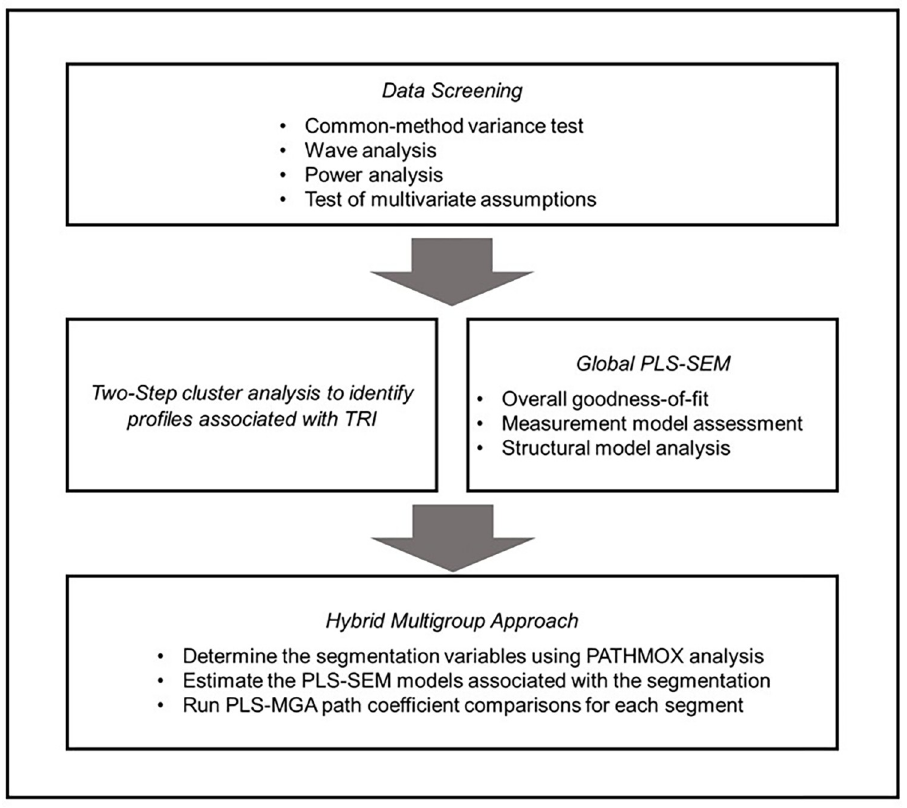
Fig 2. The general process of data